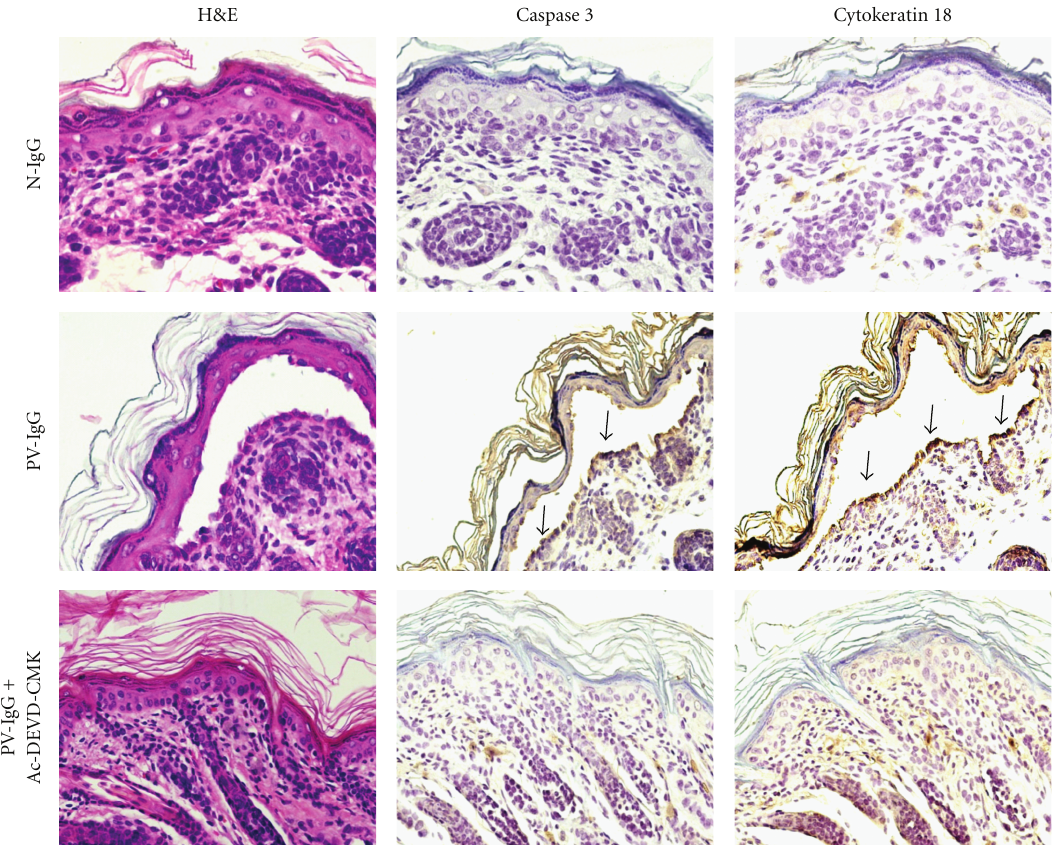
Figure 4: Caspase 3 activity detected in mouse skin. Note the presence of caspase 3 in a blister induced by the injection of pemphigus vulgaris IgG, and the presence of cytokeratin 18 detected using the antibody M30 which recognises a neoepitope of cytokeratin 18 formed after caspase cleavage. Positive immunohistochemistry was exhibited in both cases (arrows). Note the inhibition induced by the synthetic peptide Ac-DEVD-CMK in the bottom